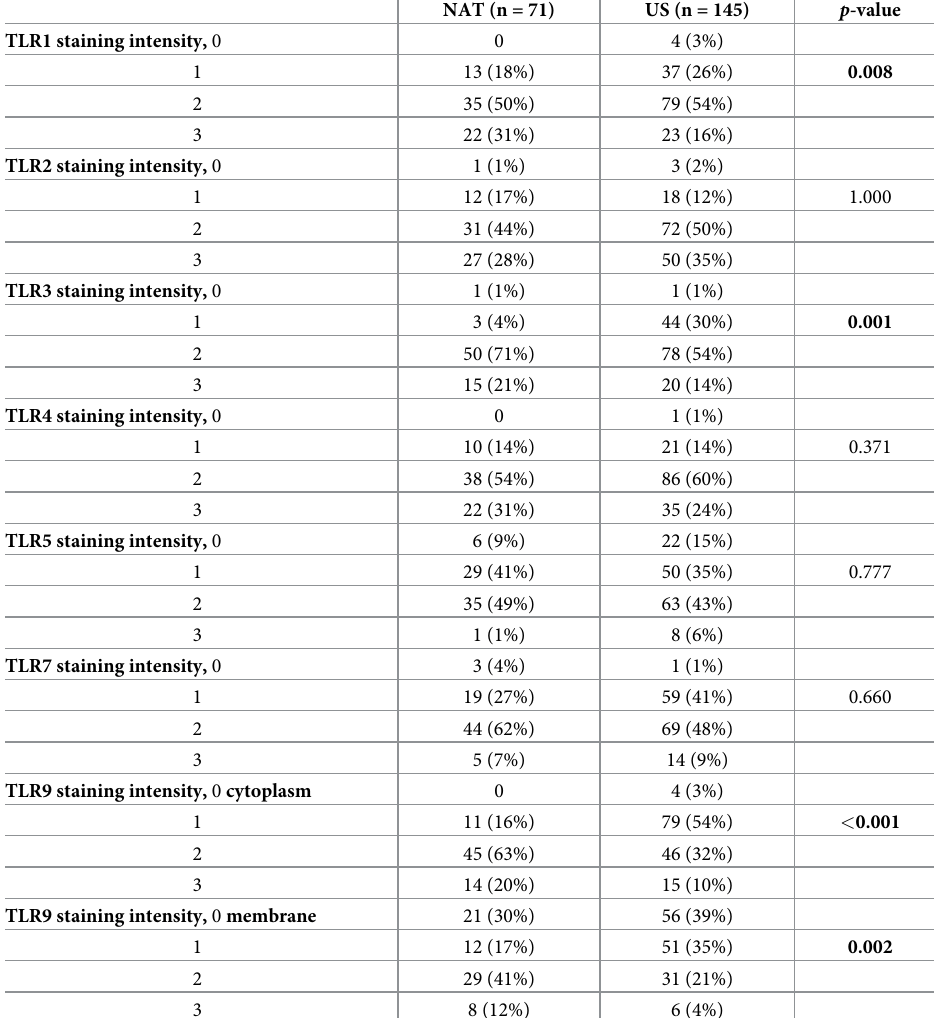
In a grouped analysis, the negativity for one or more receptors in TLRs 1, 3, 7, or 9 in patients undergoing upfront surgery (7 out of 145 patients) predicted a shorter survival [14 months (95% CI 7–21 months) vs 27 months (95% CI 21–34 months), p = 0.040]. Among NAT patients, the negative expression of one or more of these receptors did not associate with survival [30 months (95% CI 24–36 months) vs 43 months (95% CI could not be calculated due to low number of patients), p = 0.300]. Negativity for at least one of the receptors was detected only in 4 of 71 NAT patients.